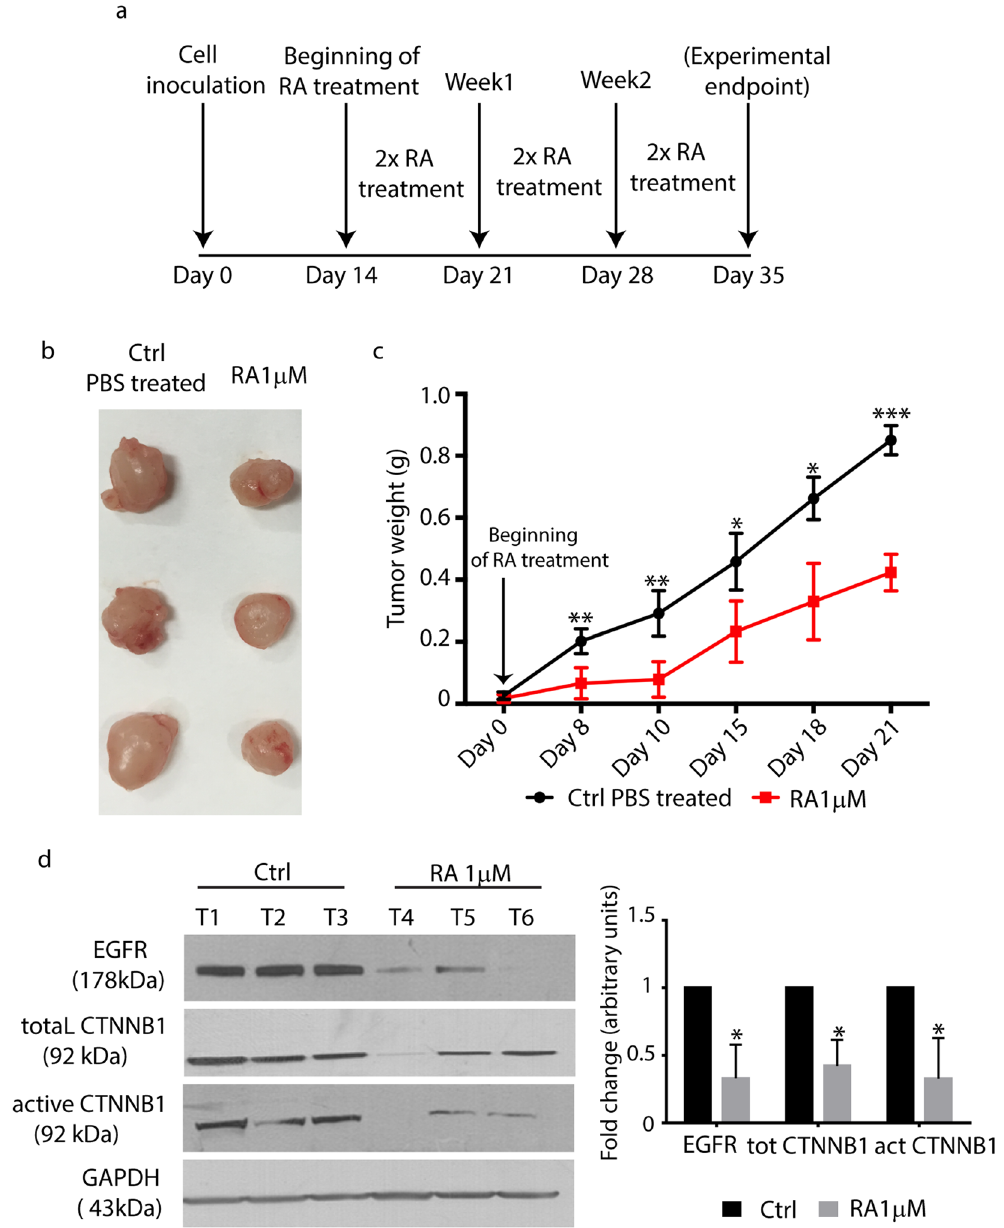
Figure 5. In vivo effects of RA on H-1975 xenografts. (a) Schematic representation of the in vivo experiment performed by injecting H-1975 cells in athymic nude mice. (b) Representative micrographs obtained after tumor harvesting (PBS treated vs 1 µ M RA treated mice). (c) Tumor weight analysis of PBS and 1 µ M RA treated mice. Tumor size was measured at the time points indicated in the x axis. Data are represented as mean ± SD ( * = 0.02, ** = 0.05, *** = 0.002, obtained by unpaired t test analysis, n = 5). (d) Left panel, Western Blotting of EGFR, GAPDH total and active- CTNNB1 from biopsies taken from PBS and 1 µ M RA treated mice. Right panel, densitometric analysis of EGFR, total and active CTNNB1 protein levels in tumor biopsies from PBS and 1 µ M RA treated groups. The analysis has been performed by using GAPDH as normalizer loading control (n = 3 for each